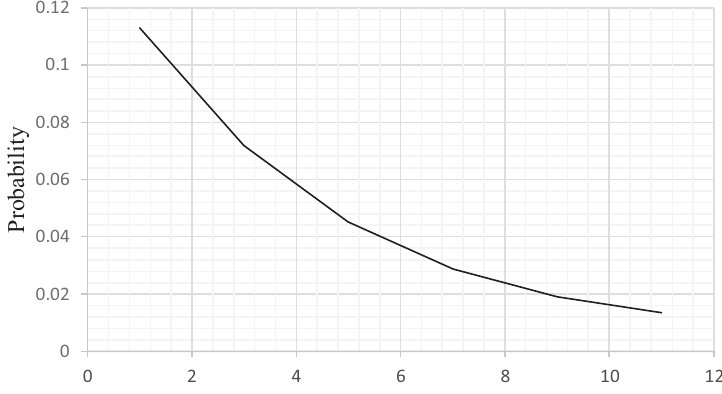
Figure 3. Distance and location choices from the RPL